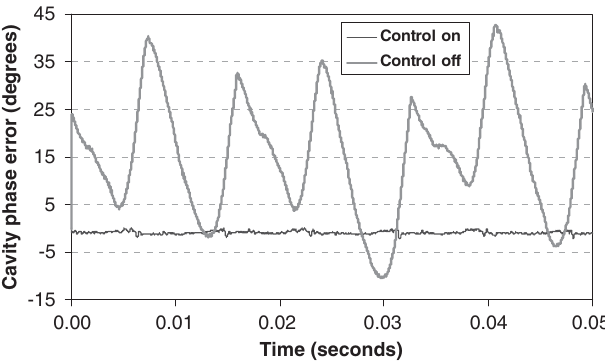
FIG. 7. Phase jitter measurement from the cavity output.